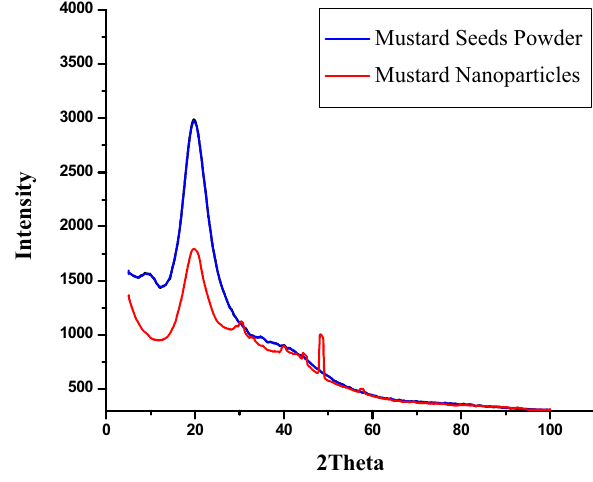
Figure 1: X - ray di ff ractograms of mustard seeds and mustard nanoparticles.